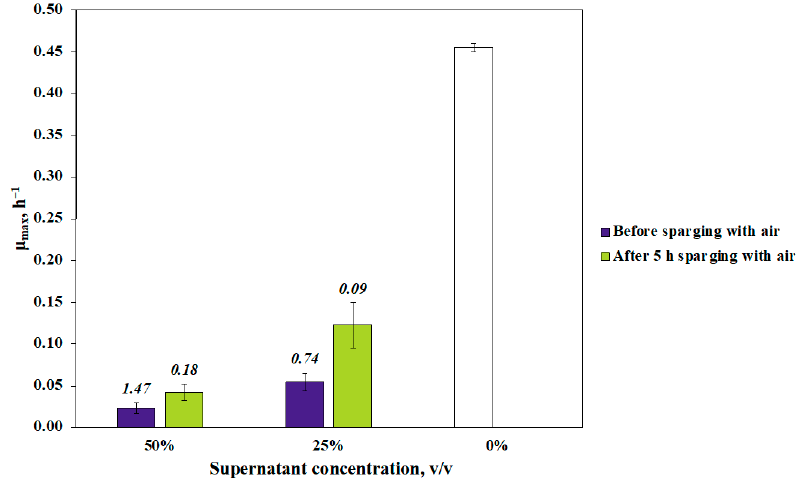
Figure 4. Effect of gassing of aerobically grown Zm4 culture supernatant with air on its growth- inhibitory properties. The acetaldehyde concentration (mM) in the E. coli culture media after addition of the Zm4 culture supernatant is shown on top of the bars. Empty bar, E. coli specific growth rate without any additions. In all cases, supernatant addition significantly decreased the growth rate ( p < 0.001).